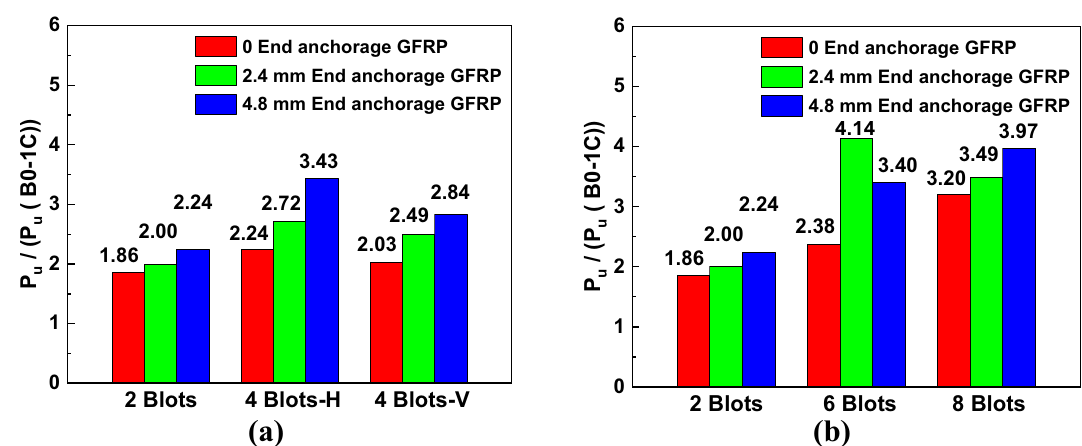
Fig. 11 Normalized ultimate load versus bolt quatity (diameter 10 mm) and end-anchorage thickness